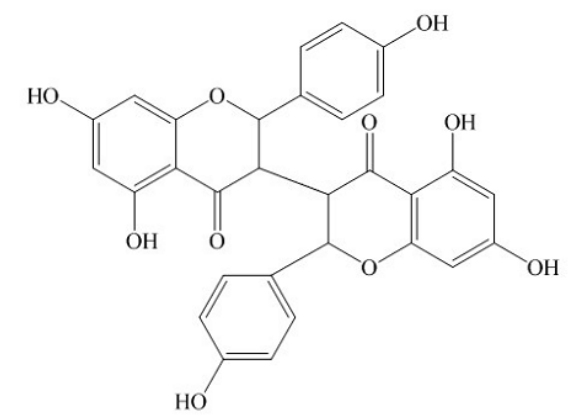
Figure 1. Chemical structure of